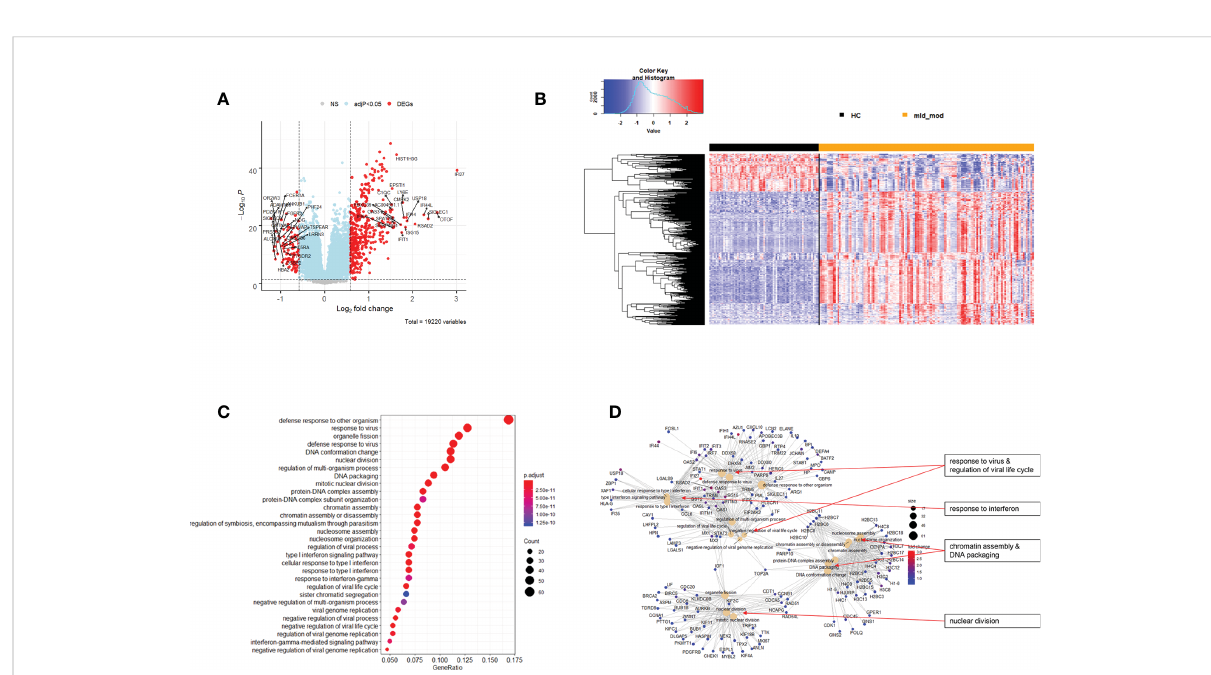
FIGURE 6 Differential genes expression analysis contrasting mild/moderate cases to healthy controls. (A) Volcano plot of results of the contrast from the linear regression analysis. y-axis: -log 10 BH multiple testing adjusted p-values, x-axis: log 2 fold change. DEGs (absolute log-fold change > 1.5, corresponding to a log 2 -fold change > 0.58; multiple testing adjusted p-value < 0.05) are colored red and the top 20 up- and down-regulated (by log-fold change) DEGs are labeled. Blue: genes with adjusted p-value < 0.05. (B) Heatmap of expression levels for DEGs. Values were scaled by row. red: up-regulated DEGs, blue: down-regulated DEGS. HC: healthy controls, mld_mod: mild/moderate pateints. (C) Functional analysis using GO term enrichment for up-regulated DEGs showing 30 most signi fi cant pathway annotations. No signi fi cant pathways could be identi fi ed for the down-regulated genes (D) cnetplot illustrating relationship of DEGs to pathway annotations. Nodes in cnetplots represent pathways signi fi cantly associated with the differentially expressed genes. The differentially expressed genes are connected to these nodes with color-coded log-fold changes from the contrast between mild/moderate cases versus healthy controls. Abbreviations: HC stands for healthy controls; mld_mod stands for mild and